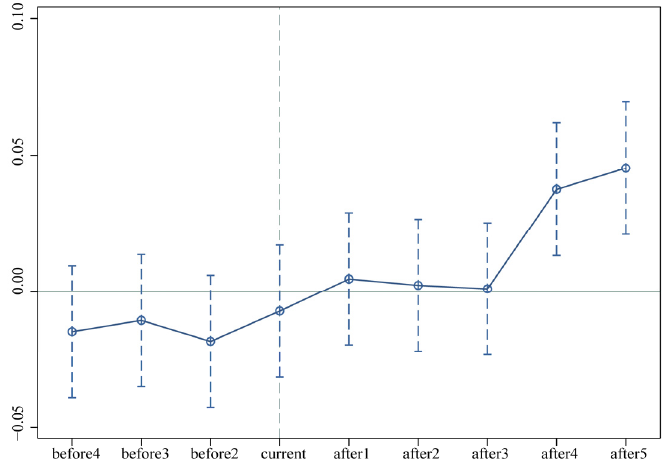
Figure 6. The dynamic effect tests.